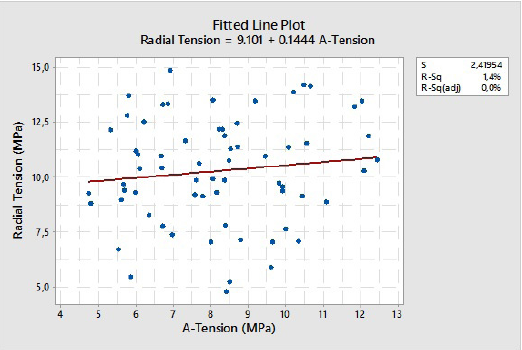
Figure 13. Plotting of the results for Radial Tension Strength and Density.